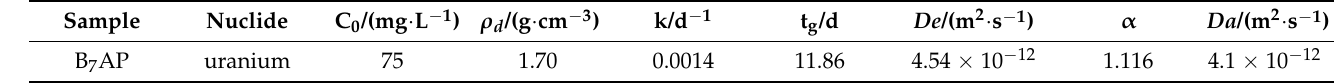
Table 1. Diffusion experimental results of uranium on B 7 AP integrated buffer